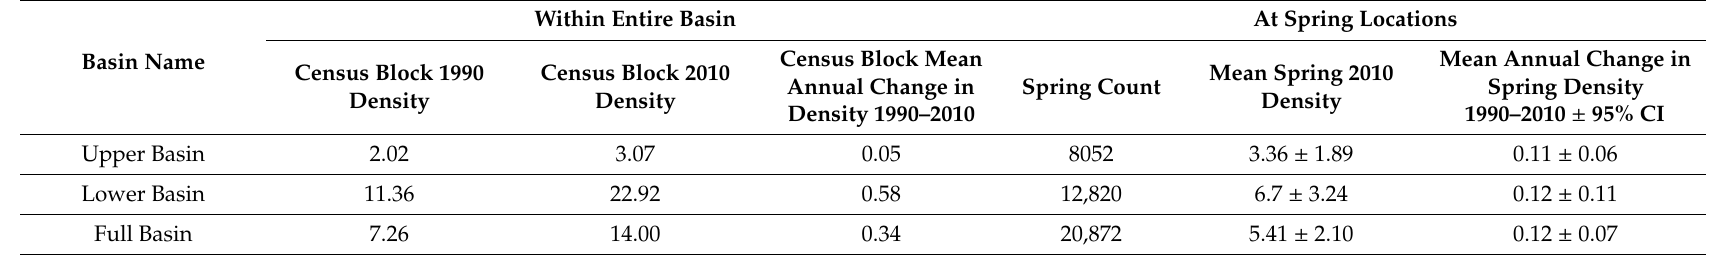
Table 3. Human population density (people / km 2 ) and change in population by sub-basin and in the Colorado River Basin overall, and in the vicinity of springs from 1990 to 2010. Total population estimates in the sub-basins and the overall basin are provided in the text. Paired between-year and inter-sub-basin comparisons are significantly di ff erent at P <